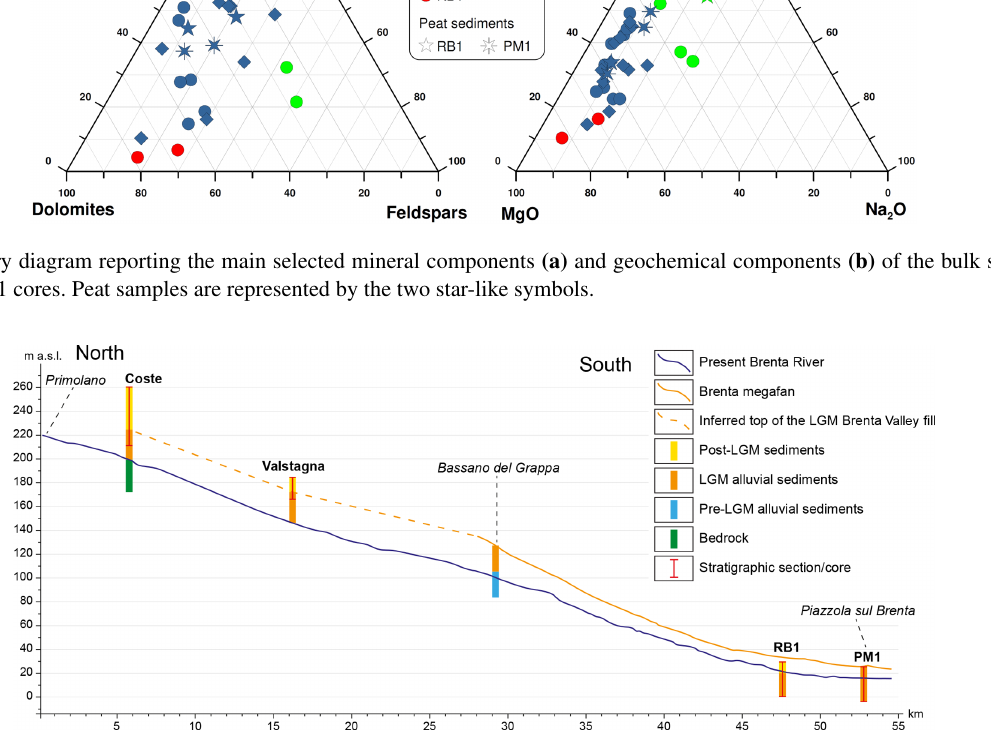
Figure 9. Longitudinal profiles of the present Brenta River (blue solid line), from Primolano to Piazzola sul Brenta, including the Brenta megafan (orange solid line), from the apex to Piazzola sul Brenta, and the possible profile of the Brenta Valley bottom during the LGM (orange dashed line), inferred from stratigraphic sections. The age of sediments/bedrock is shown using different